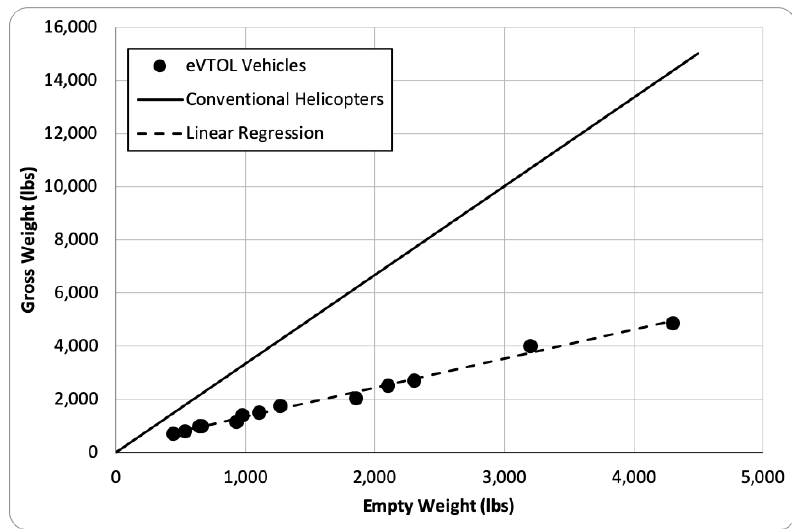
Figure 2. Gross weight as a function of empty weight for conventional and electric helicopters. Table 1. Battery, motor and inverter technology assumptions